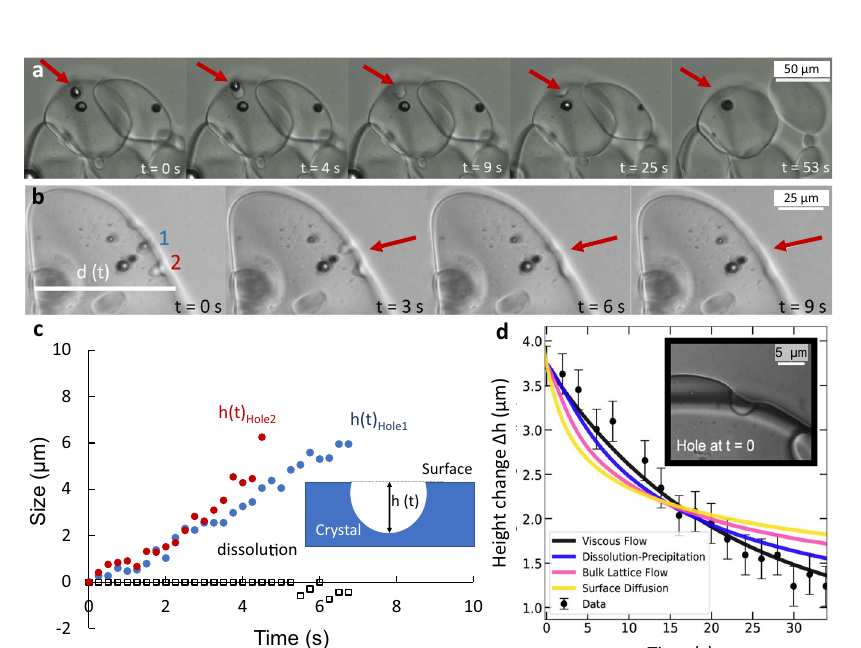
Fig. 2 | Assembly of mirabilite microcrystals above the deliquescence point. a Non-faceted mirabilite microcrystals are deformable and adapt their shape to neighboring crystals in the sodium sulfate solution. b Raman spectrum of the